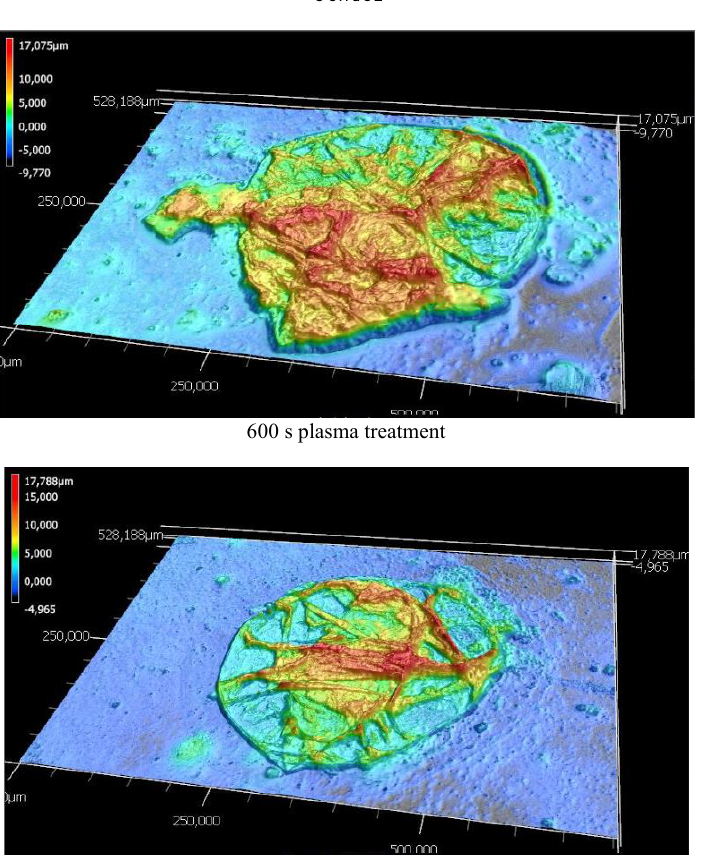
Figure 4. Comparison of the juice’s sample before and after plasma treatment, depth analysis with Keyence VK-X1000 laser microscope.